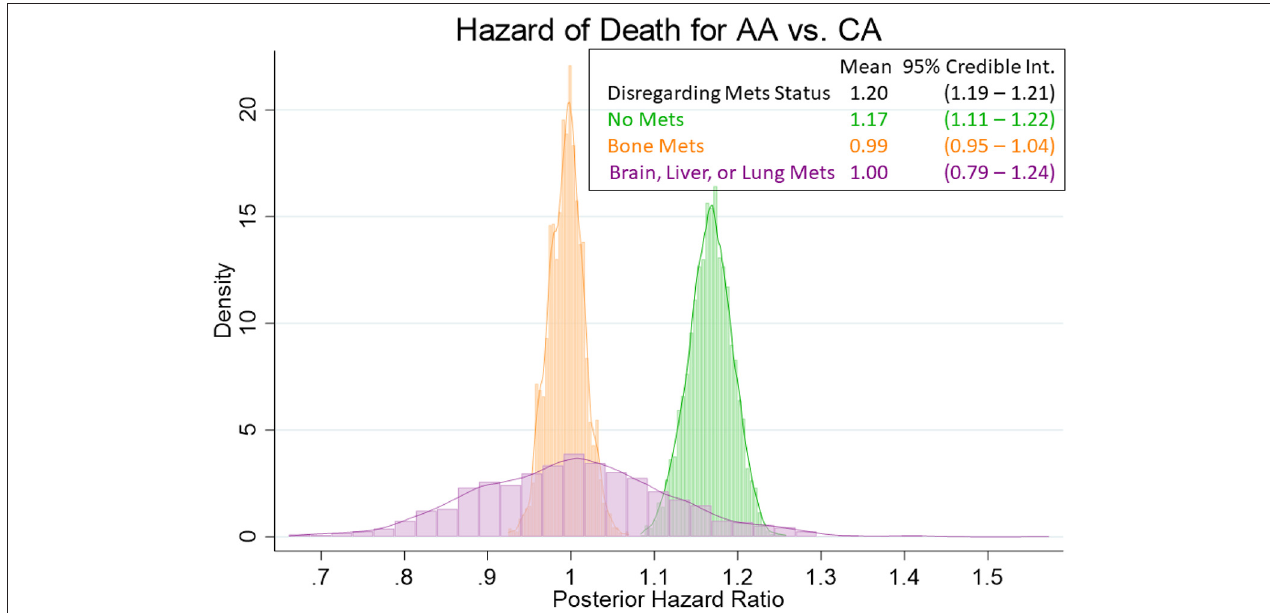
FIGURE 2 | Posterior distributions of hazard ratios for the African American main effect. Posterior hazard ratios come from Bayesian Weibull models with informative Cauchy (log (2), 0.5) priors on the African American main effect. The histograms (coupled with analogous estimates) show that there is a demonstrable (if not modest) racial effect on the hazard of death for those men without metastasis (HR = 1.17), as well as with the overall cohort (HR = 1.20). However, the racial disparities are virtually nonexistent for those mean with bone metastasis (HR = 0.99) or with brain, liver, or lung metastasis (HR =